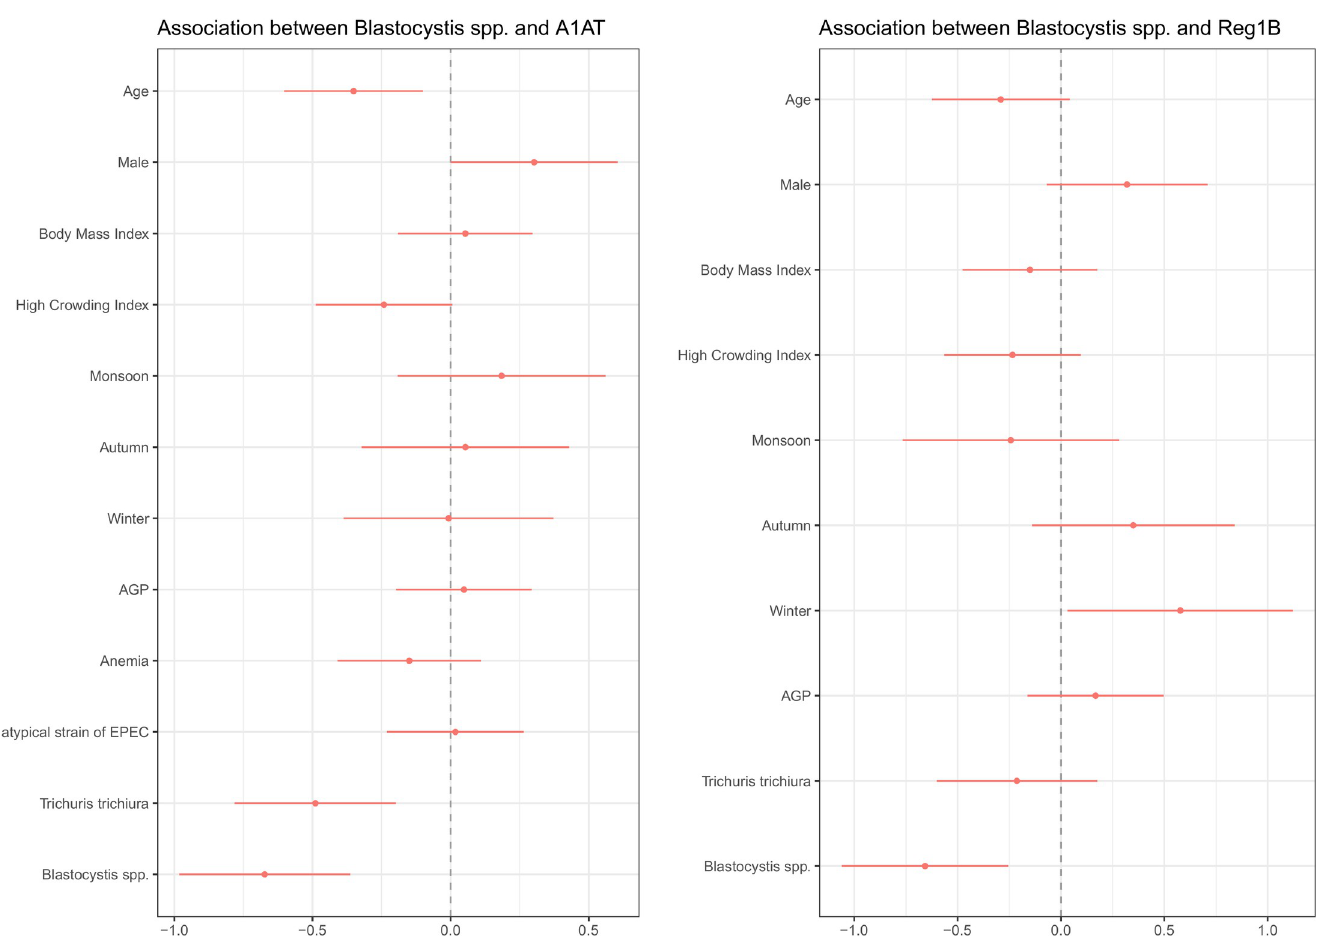
Fig 3. Forest plots showing the relationship between Blastocystis and fecal biomarkers of Environmental Enteric Dysfunction in malnourished adults. The illustration on left side demonstrates the association between Blastocystis and A1AT, while the photograph in right side shows the relationship between Blastocystis and Reg1B. The results were obtained by multivariable linear regression analyses after adjusting for the variables with p-values < 0.20 in the univariate linear regression analysis. Herein, the fecal biomarkers, for instance, A1AT and Reg1B, were the dependent variables. A1AT, alpha-1 anti-trypsin; Reg1B, Regenerating Family Member 1 Beta; AGP, alpha-1-acid glycoprotein; EPEC, enteropathogenic Escherichia coli .